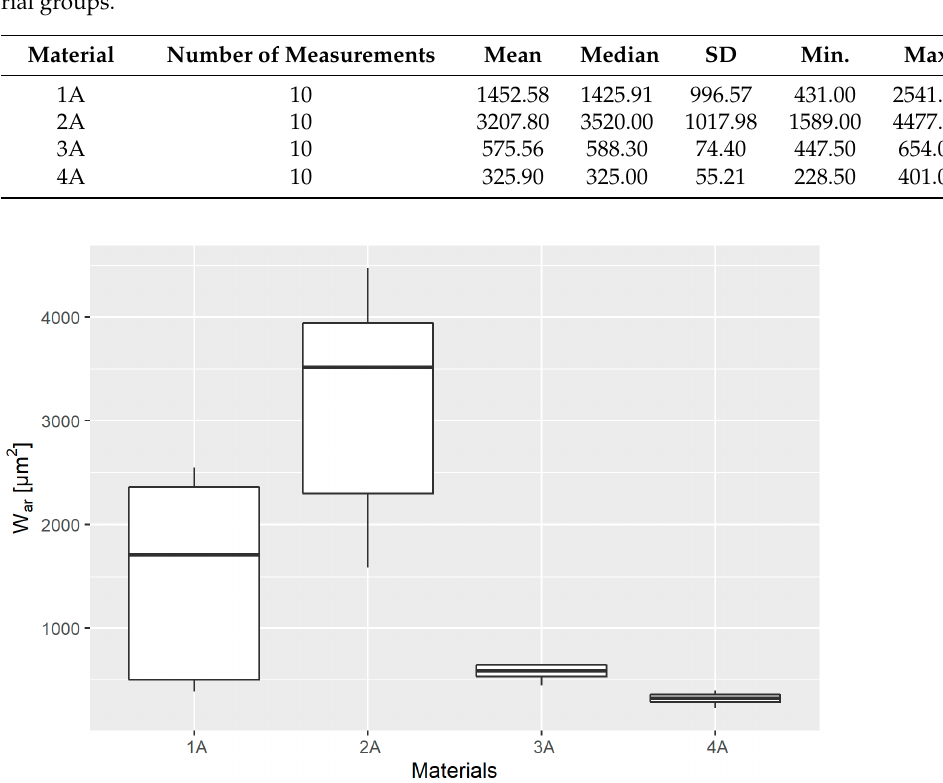
Table 12. Basic descriptive statistics of tribological wear measurement results in individual mate- rial groups.